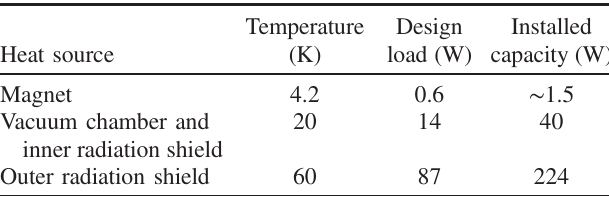
TABLE II. Design heat loads and installed cooling capacity.